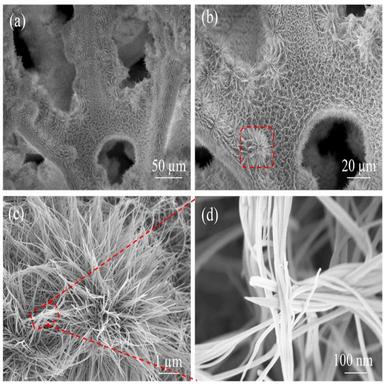
(a–b) Low magnification SEM images, (c–d) High magnification SEM images of Co3O4@NF-16h sample.